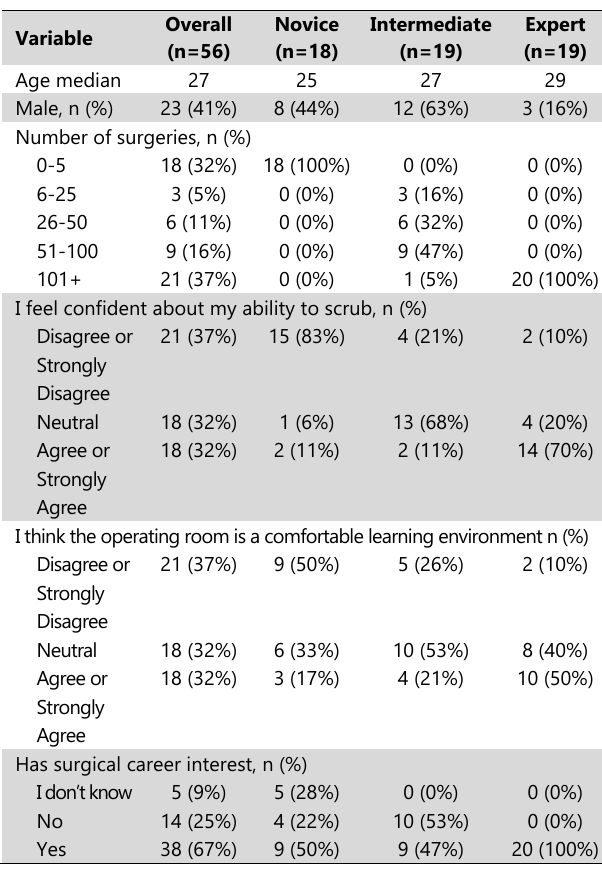
Table 2. Baseline Demographic